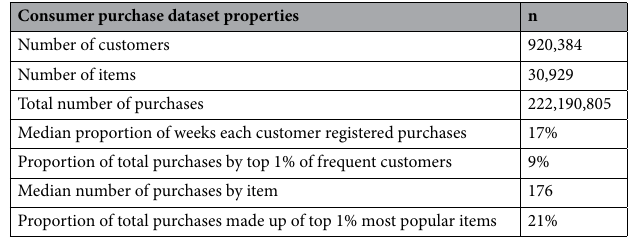
Table 1. Descriptive statistics of our consumer purchase dataset.